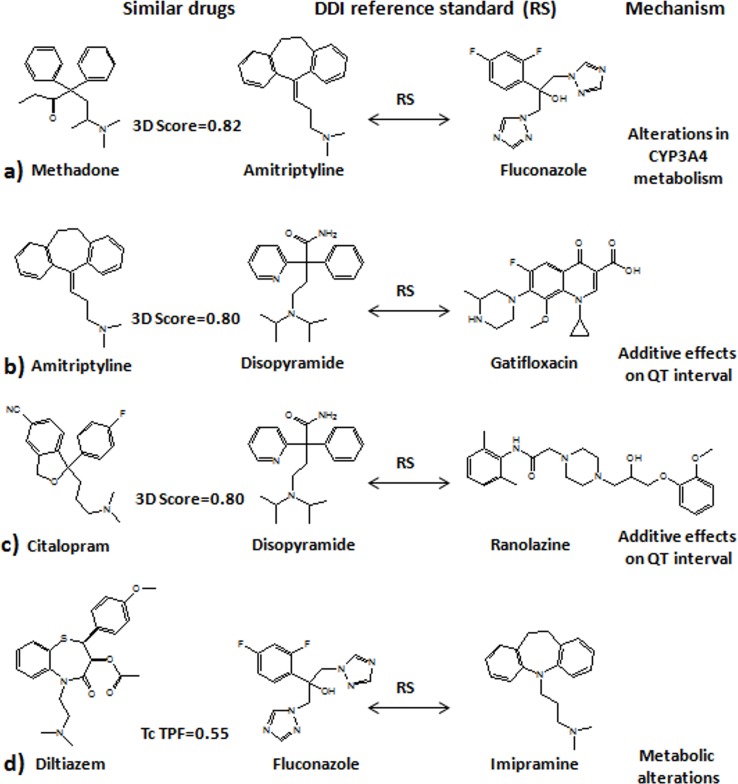
Examples of different pairs of similar drugs with different pharmacological profile detected by our models.Panel (a): methadone is similar to amitriptyline and predicted to interact with fluconazole (reference standard amitriptyline-fluconazole). Panel (b): amitriptyline is similar to disopyramide and predicted by the 3D model to interact with gatifloxacin (reference standard disopyramide—gatifloxacin). Panel (c): citalopram, was found to be similar to disopyramide and hence, to interact with ranolazine (reference standard disopyramide-ranolazine). Panel (d): diltiazem was found to be similar to fluconazole and predicted to interact with imipramine (reference standard fluconazole-imipramine).